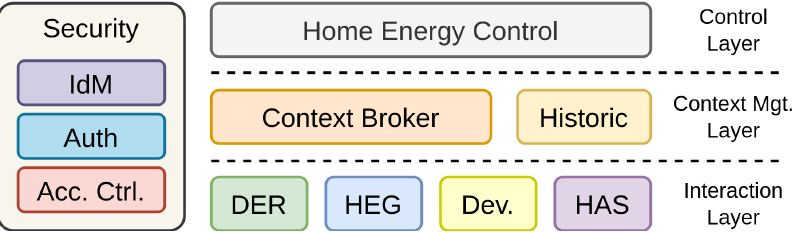
Figure 4. Layered architecture of the Smart Home Energy Management